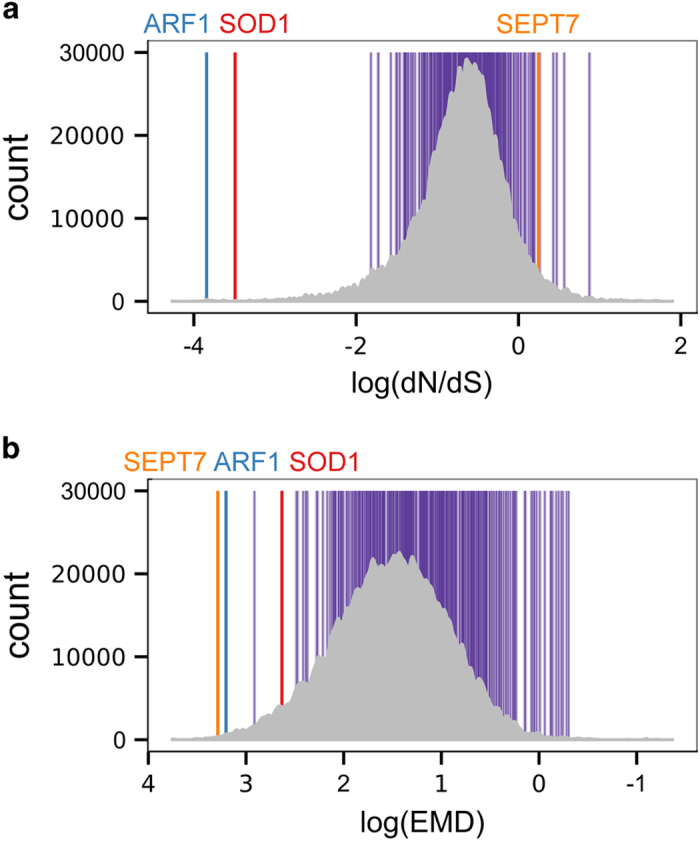
Prioritisation of variant-affected genes from the proband. Comparison of variant-affected genes from the proband (vertical lines) compared with the distribution for all genes in the exome (histogram). (a) Evaluation by dN/dS from population exomes, a lower score indicates higher priority. (b) Evaluation using Earthmover's distance, a measure for potential MDR-containing gene. Candidates ARF1, SEPT7 and SOD1 are highlighted in coloured vertical lines.